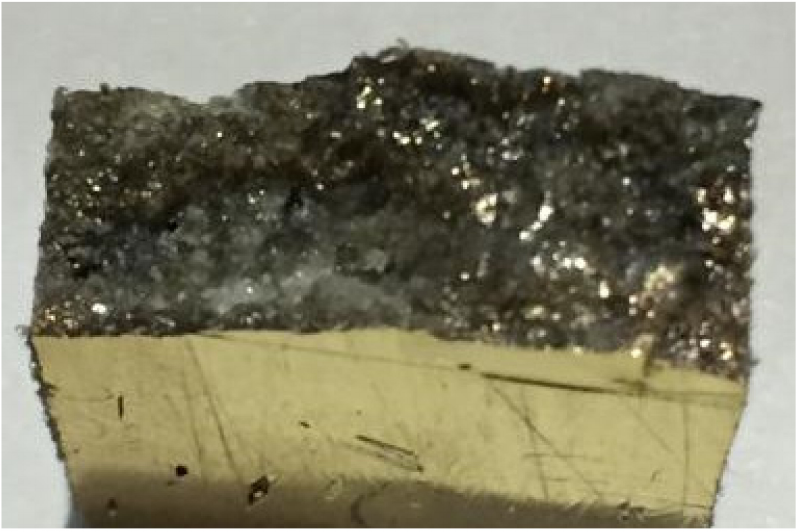
Figure 4. Cross section of sample after being coated with gold.